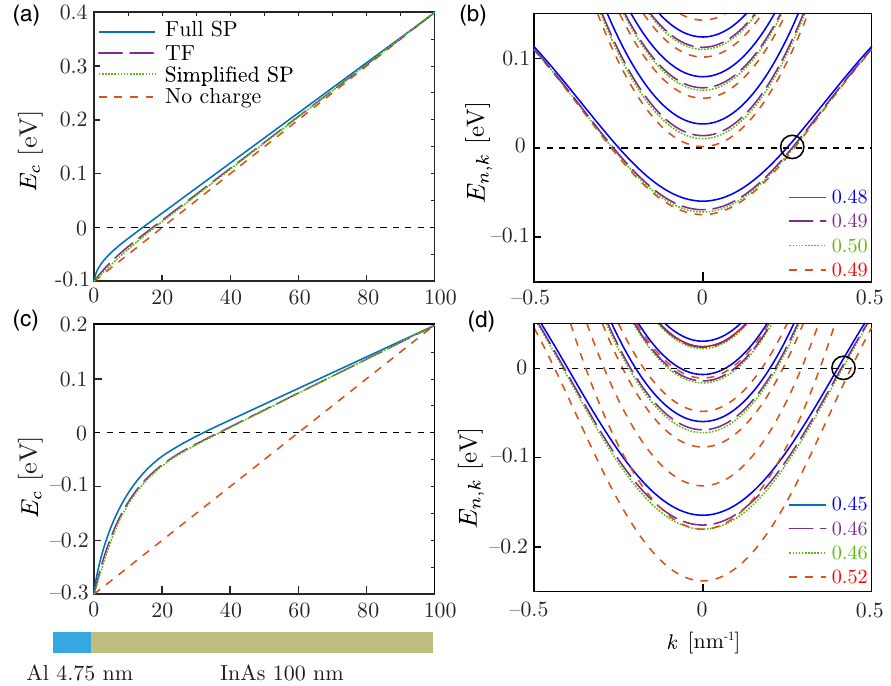
FIG. 10. Self-consistent band edge profiles and band structures obtained using the methods described in Appendix B with L 1 ¼ 4 . 75 nm and V − 0 . 5 V. Results for both Φ ¼ 0 . 1 eV and Φ ¼ 0 . 3 eV are shown. (a) Band edge profiles obtained for Φ ¼ 0 . 1 eV. D ¼ (b) Band structures obtained for Φ ¼ 0 . 1 eV. The numbers in the lower left-hand corner are the weights at the Fermi energy of the bands marked by the black circle. (c) Band edge profiles obtained for Φ ¼ 0 . 3 eV. (d) Band structures obtained for Φ ¼ 0 . 3 eV. The numbers in the lower left-hand corner are the weights at the Fermi energy of the bands marked by the black